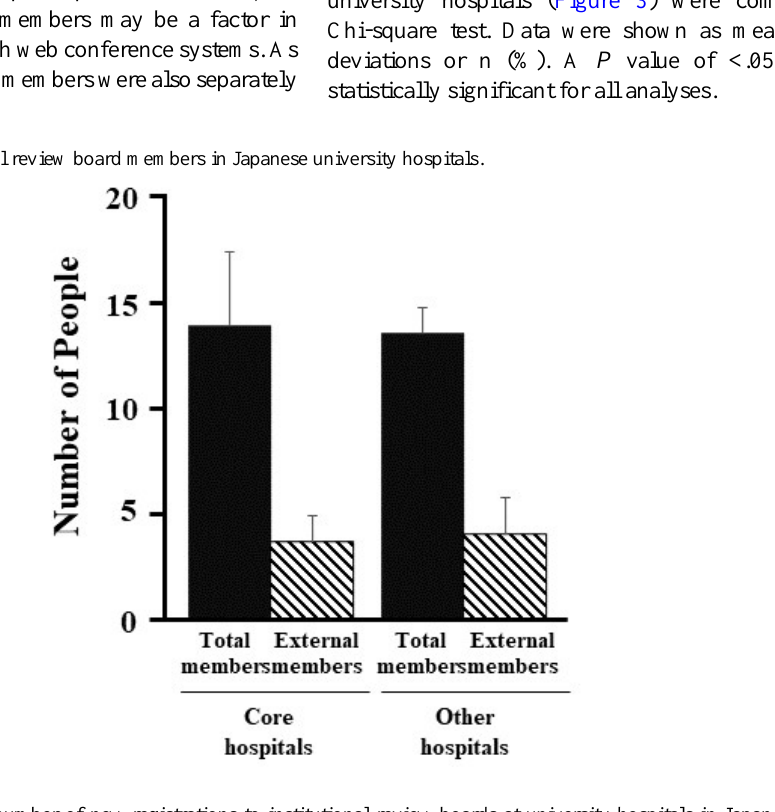
Figure 2. Comparison between the number of new registrations to institutional review boards at university hospitals in Japan before and after the COVID-19